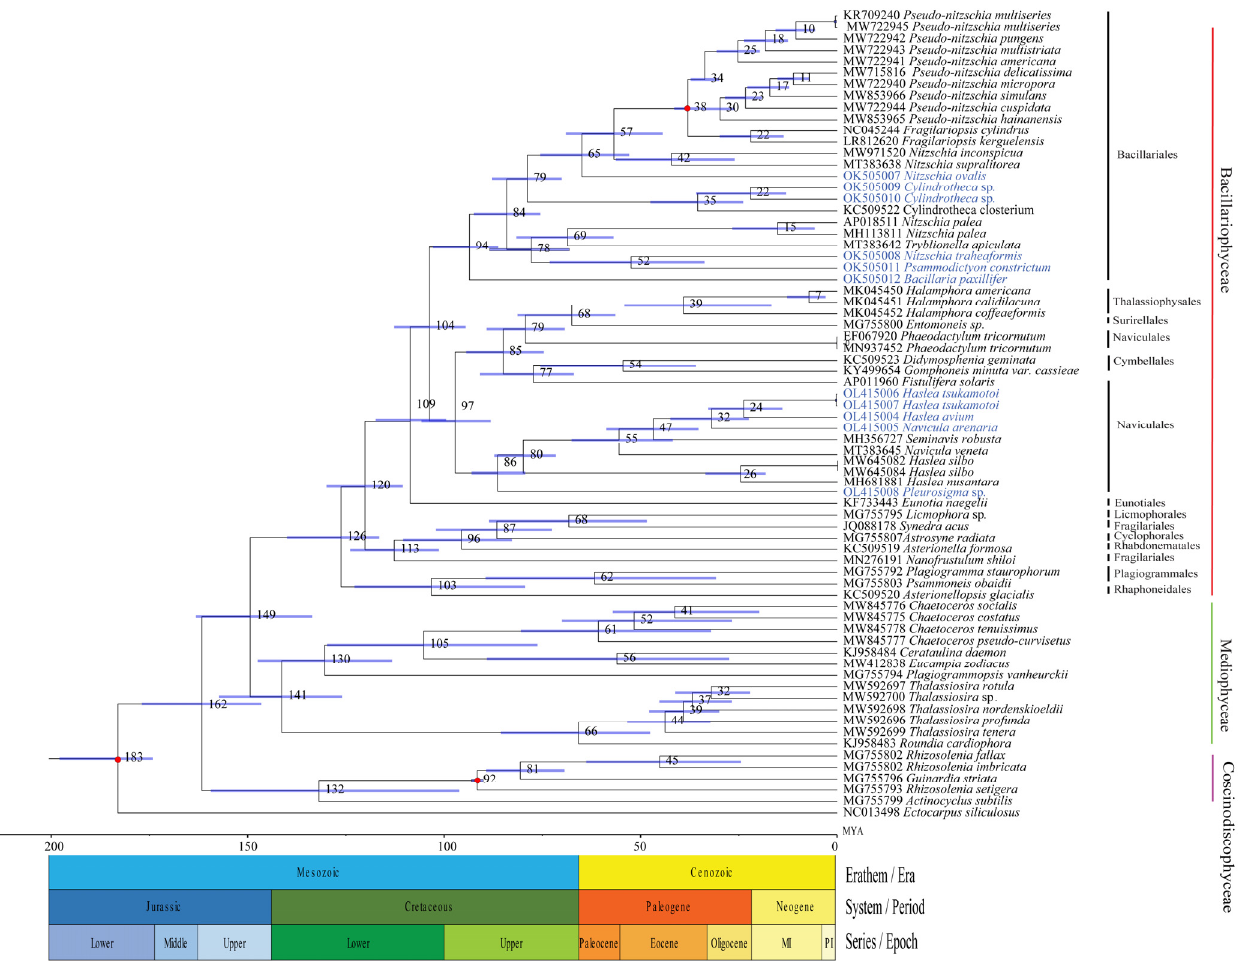
Figure 9. Time-calibrated phylogeny of cpDNAs of Bacillariophyceae species. The red dots represent calibration point and the 95% highest posterior density interval for node ages are shown with translucent blue bars.